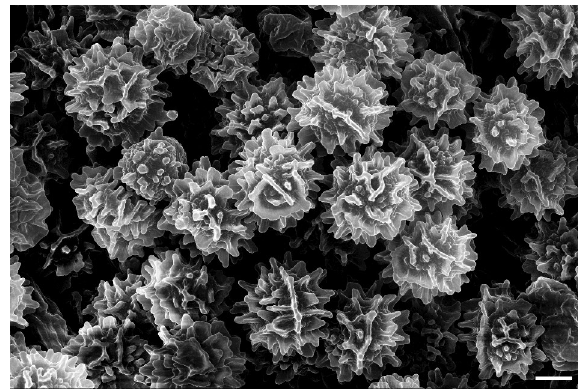
Figure 5. Scanning electron microscope photo of spore ornamentation. Russula bellissima (holotype, FH 12-127). Scale bar = 2 μm.